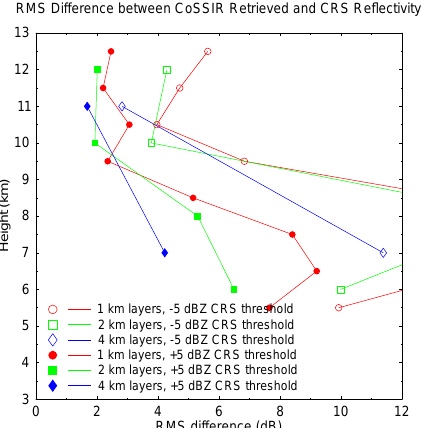
Fig. 18. RMS differences between CoSSIR retrieved and CRS 94GHz reflectivity as a function of height. The six curves are for different averaging layer thickness and minimum CRS reflectivity threshold. The marker is plotted at the center of each layer.